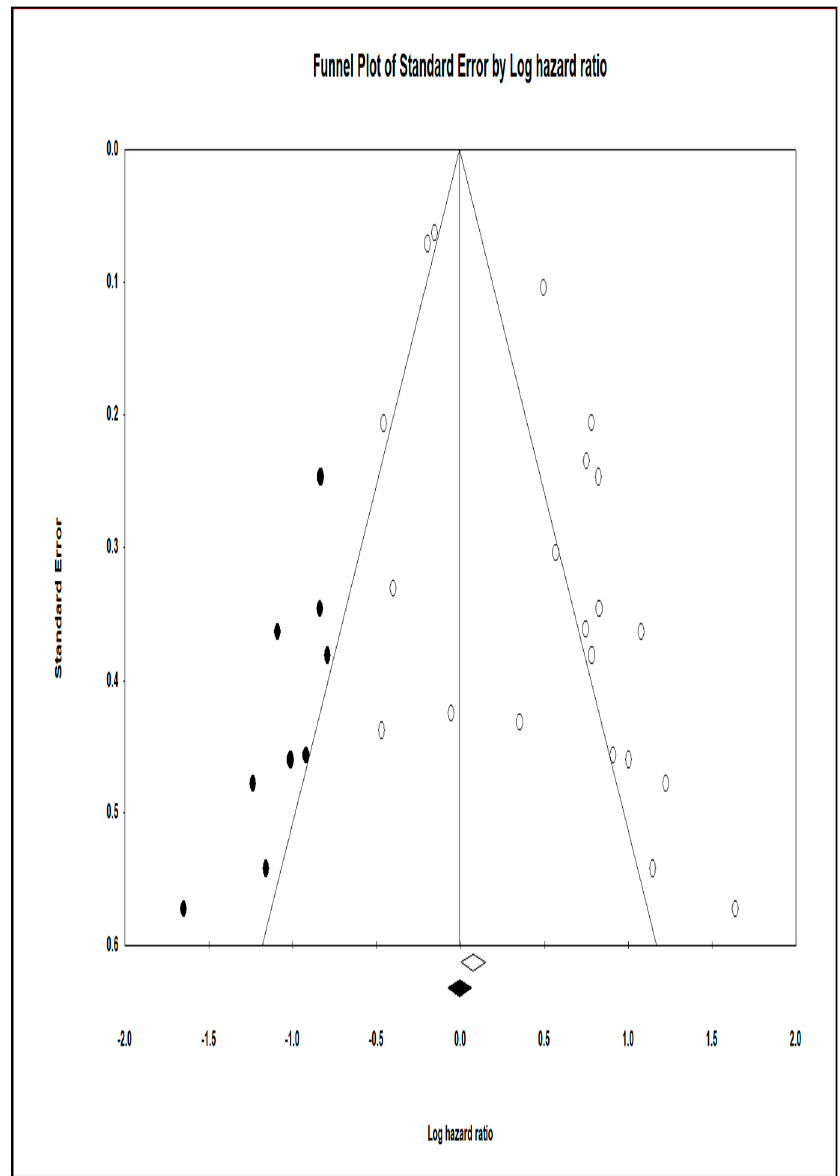
Figure 4 . Funnel plot with observed and imputed studies. Figure 4. Funnel plot with observed and imputed